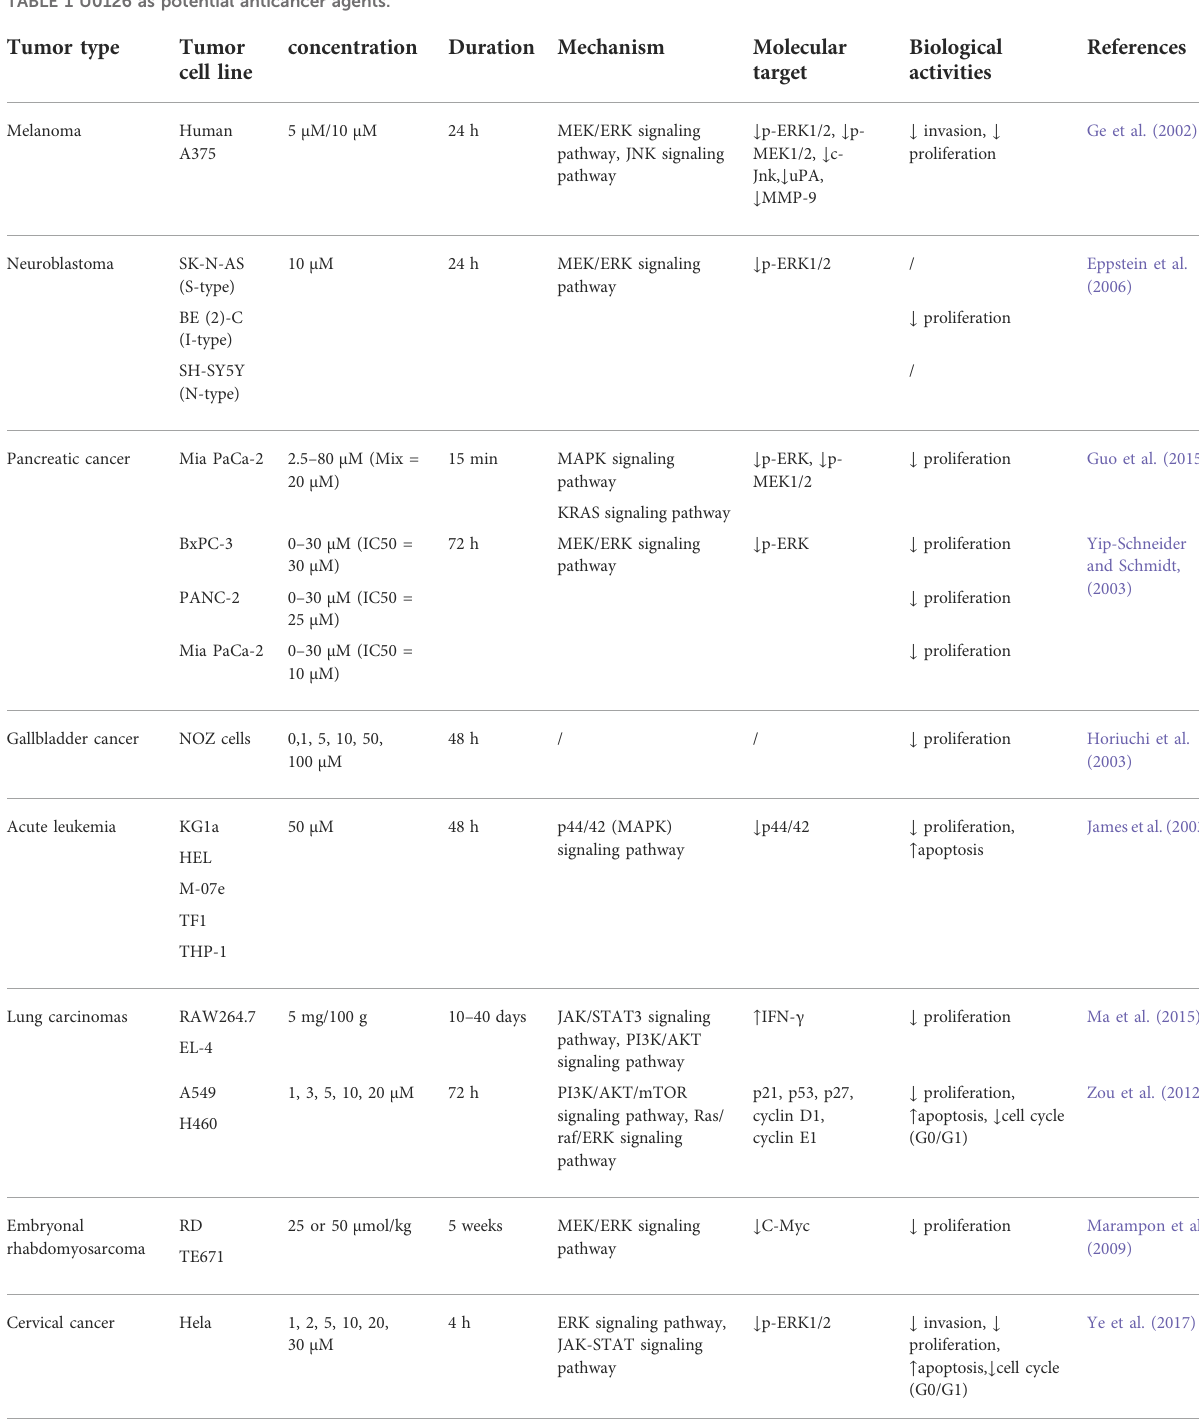
TABLE 1 U0126 as potential anticancer